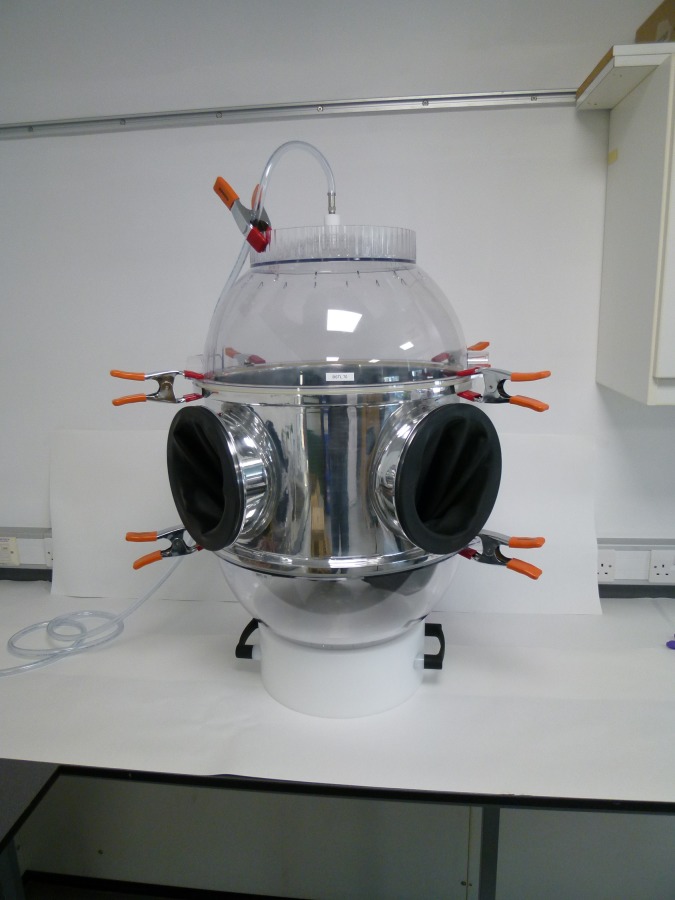
Biopharma Stability Testing Laboratory modified National Institute for Occupational Safety and Health test chamber with aluminum extension piece.